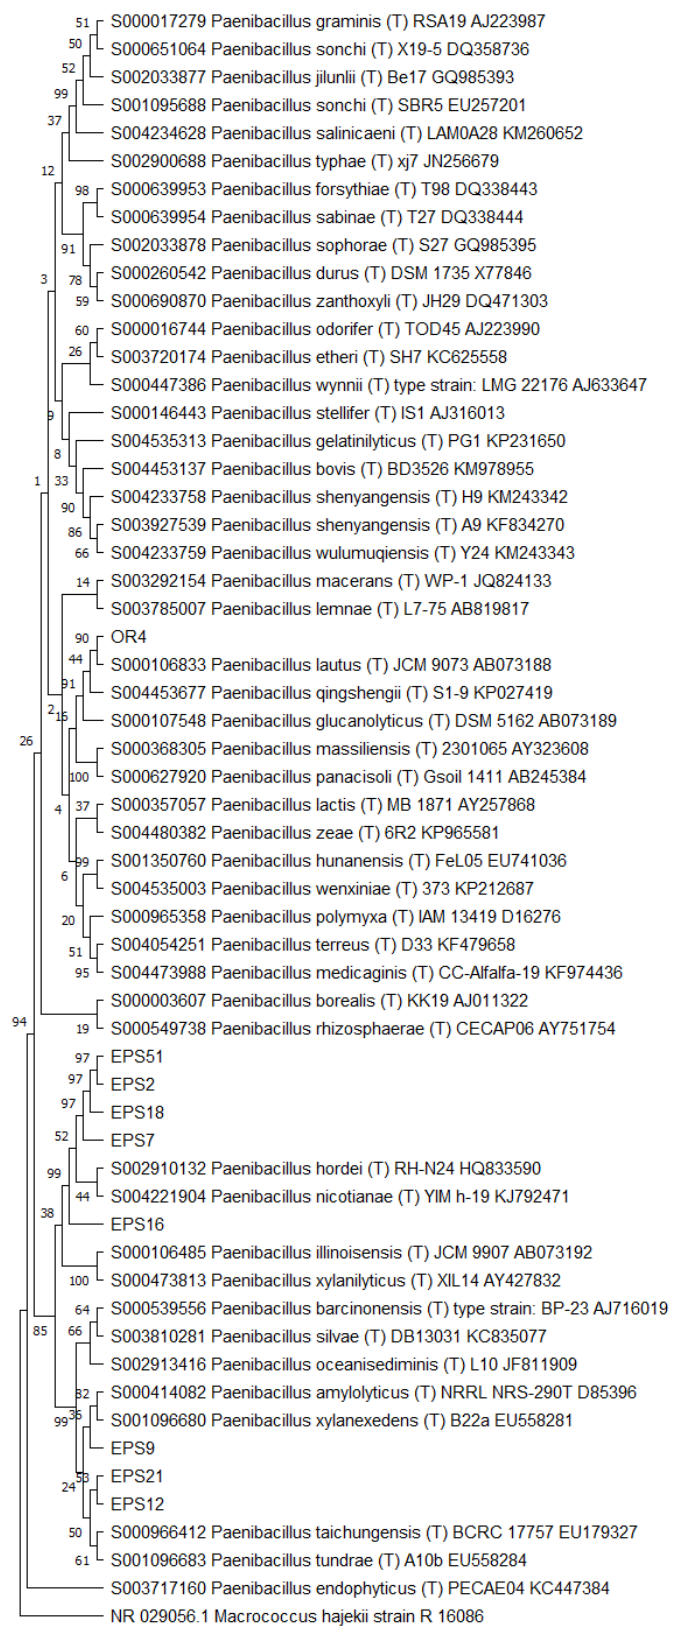
Figure 6. Phylogenetic tree for the genus Paenibacillus.